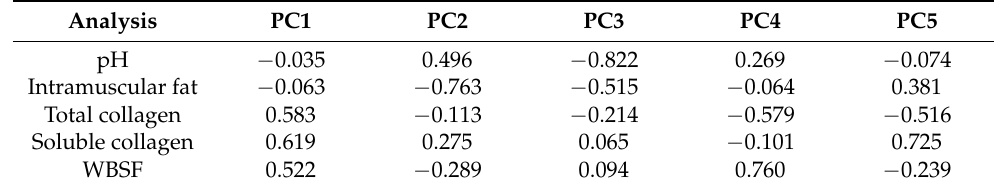
Table 2. Rotated matrix with the contribution of each principal component to every single